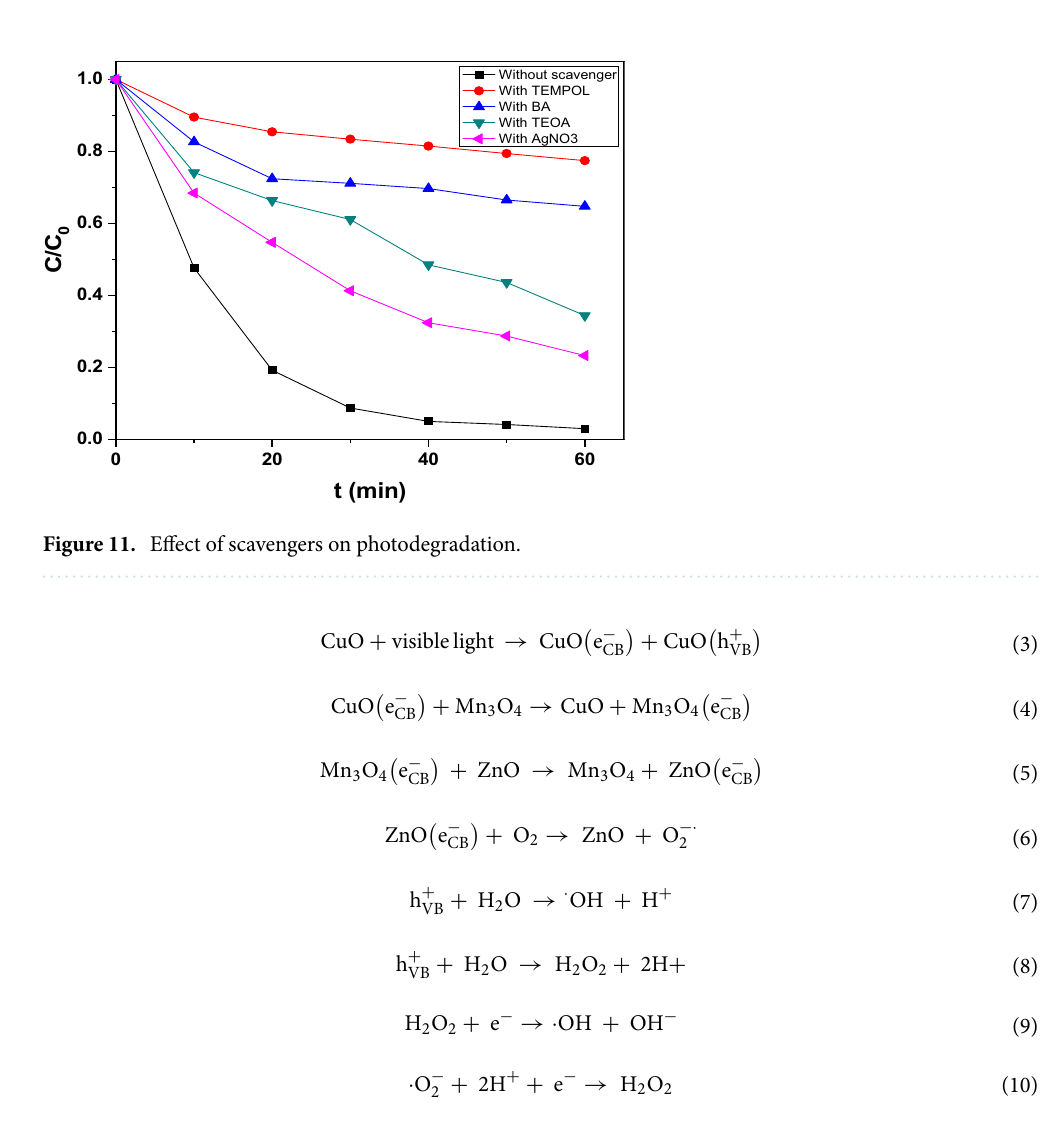
Figure 10. Release of various metal ions with time from different samples.